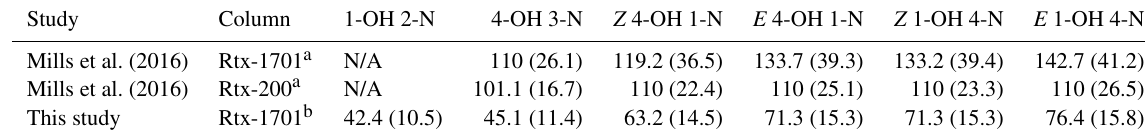
Table 2. Comparison of elution temperature ( ◦ C) and retention time (minutes, in parentheses) for isoprene nitrates. Study Column Mills et al. (2016) Mills et al. (2016)